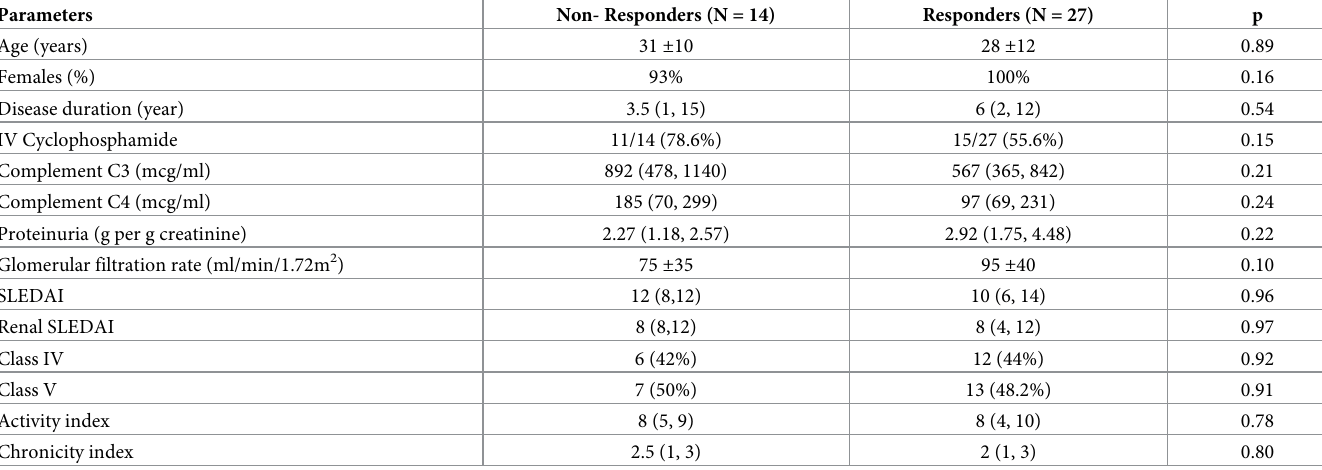
Table 2. Baseline clinicopathological characteristics of active lupus class III or IV by response to induction therapy at 6 months (N = 41).